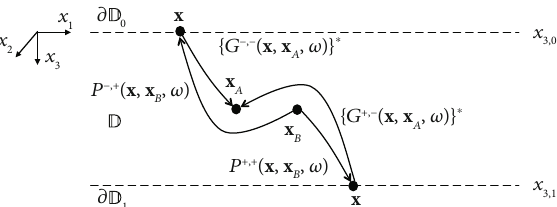
Figure 4: Visualisation of the di ff erent terms in the fi eld-normalised one-way Kirchho ff -Helmholtz integral for backward propagation, formulated by equation